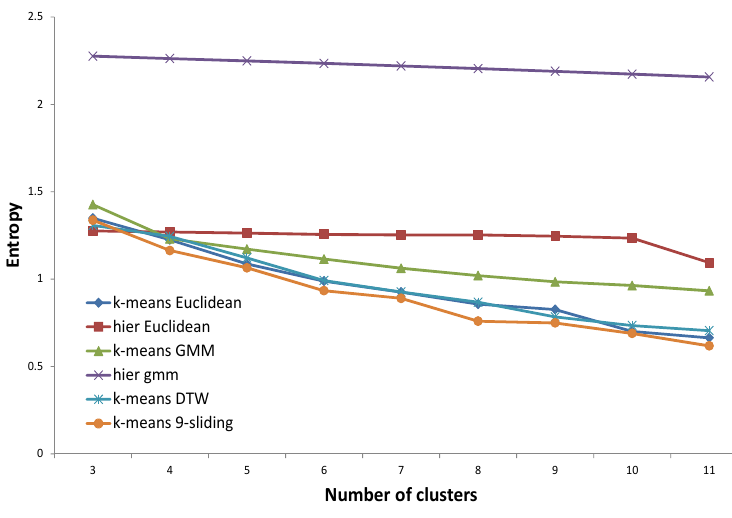
Figure 13. Entropy results of virtual